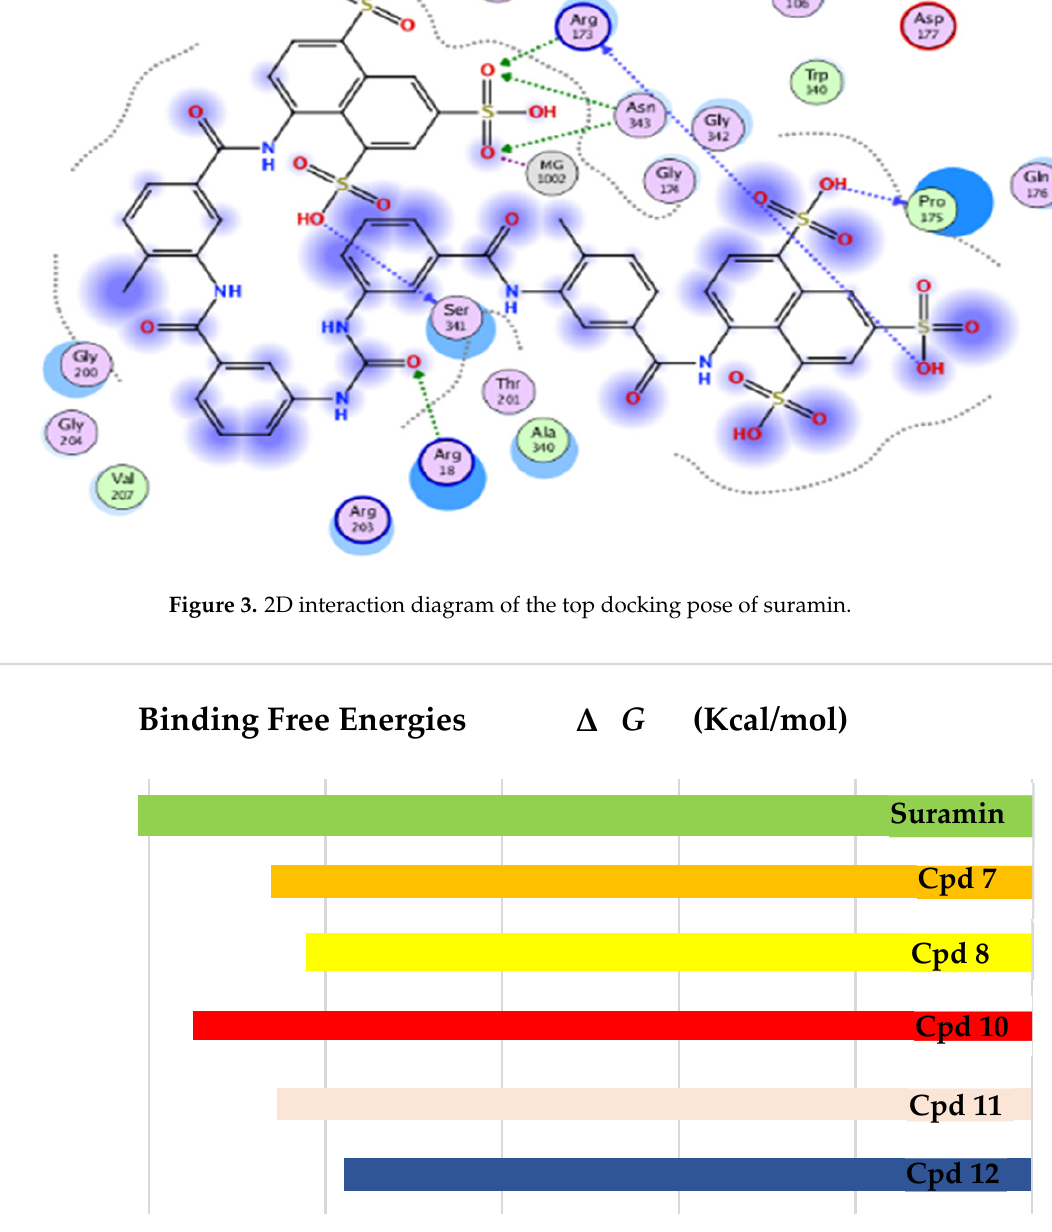
Figure 2. 2D interaction diagram of the top docking pose of the isolated compounds.